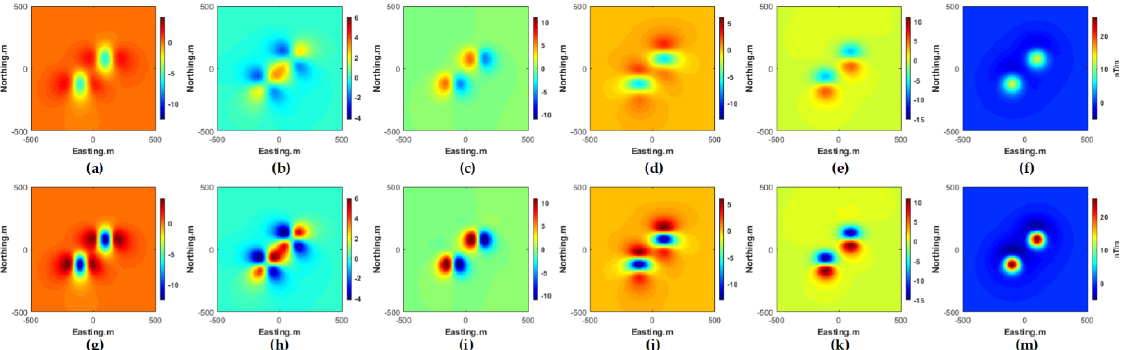
Figure 12. Comparison of the Rectangle_2B model’s components and prediction model’s components.